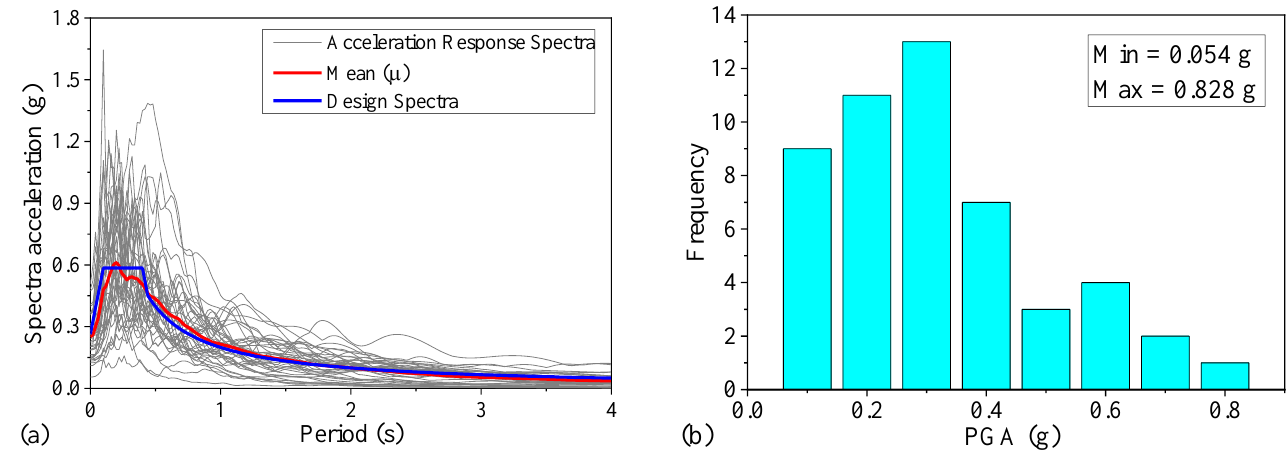
Figure 5. Acceleration spectra and PGA distributions of the records: ( a ) acceleration spectra and ( b ) PGA